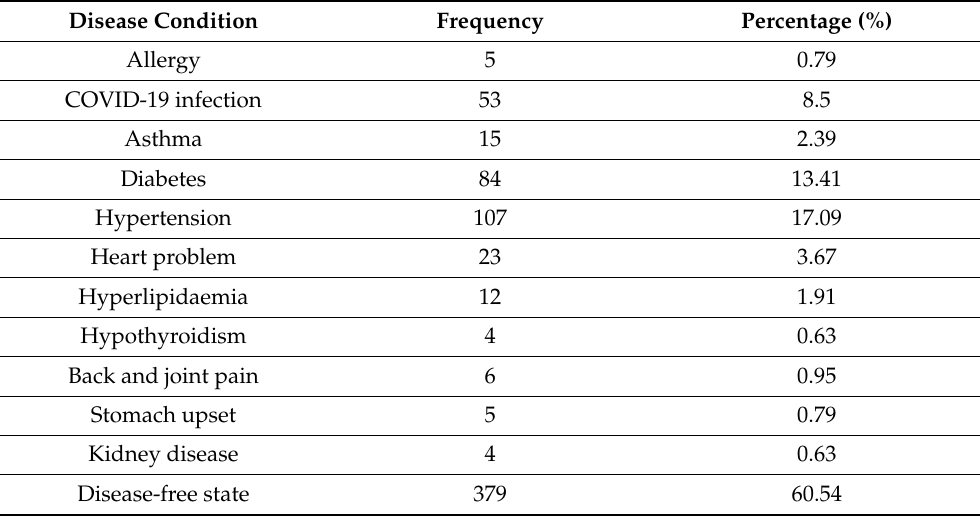
Table 2. Pre-existing disease conditions reported by the 623